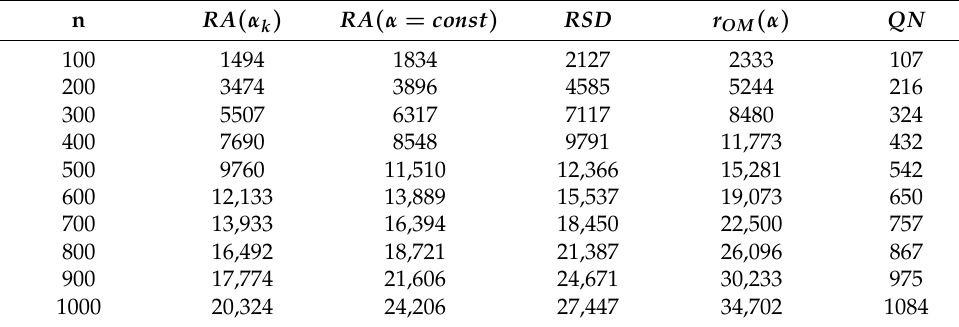
Table 1. Function f 1 ( x ) minimization